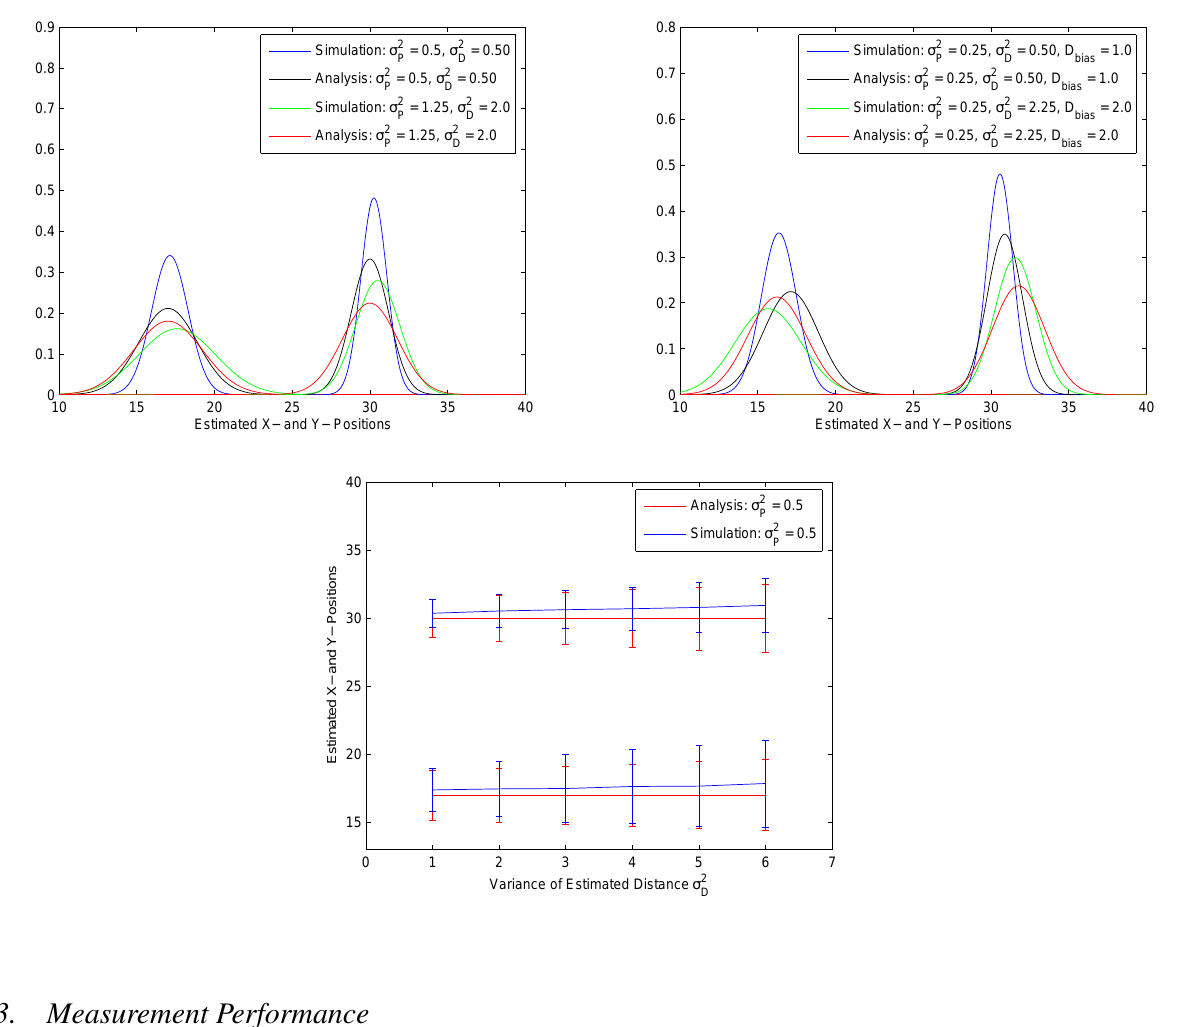
Figure 9. The distributions of simulation results and the theoretical approximation of initial position estimates with unbiased distance and position information (top left) and biased measurement information (top right); the estimated sensor position versus the variance of the distance measurement for simulation results and theoretical approximation